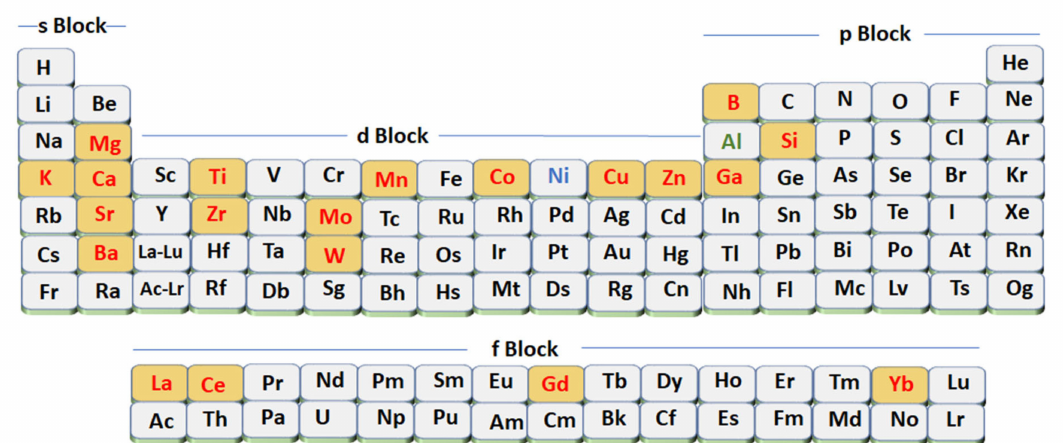
Figure 1. Active elements in a doped/promoted Al 2 O 3 -supported Ni catalyst system for dry reforming of